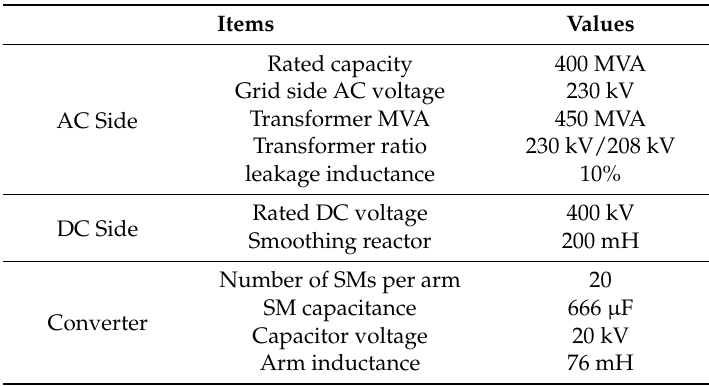
Figure 9. Structure of the hybrid HVDC breaker. Table 1. Main Circuit Parameters of the MMC.